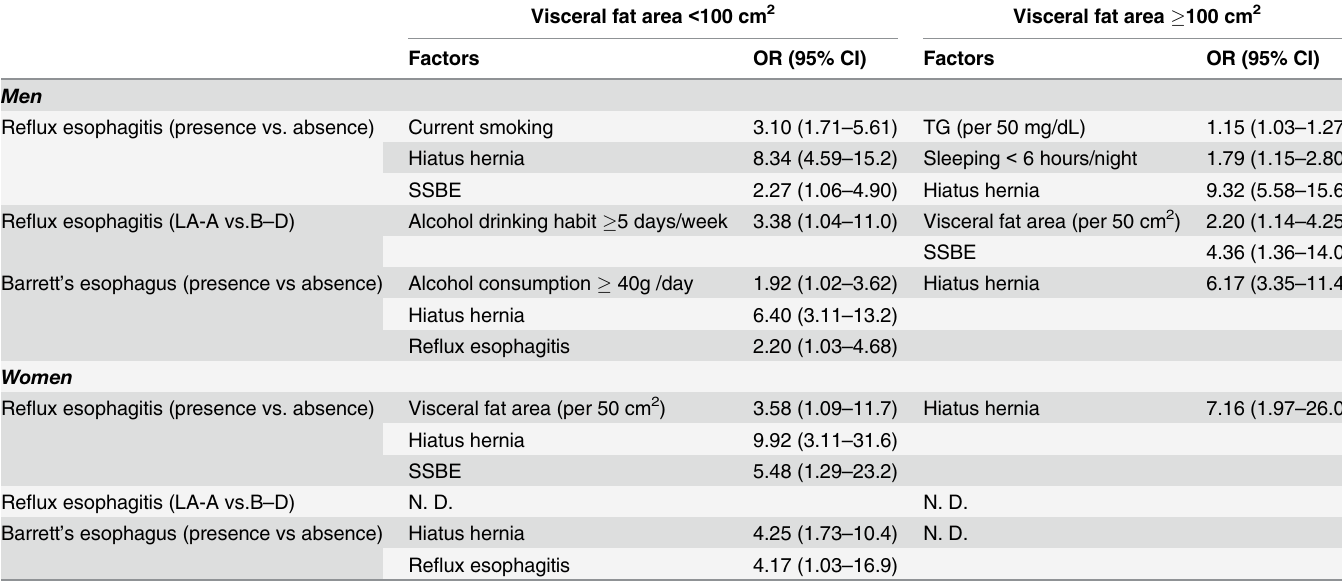
Table 6. Associated factors for reflux esophagitis or Barrett ’ s esophagus in obese and non-obese subgroups: multivariable analysis †